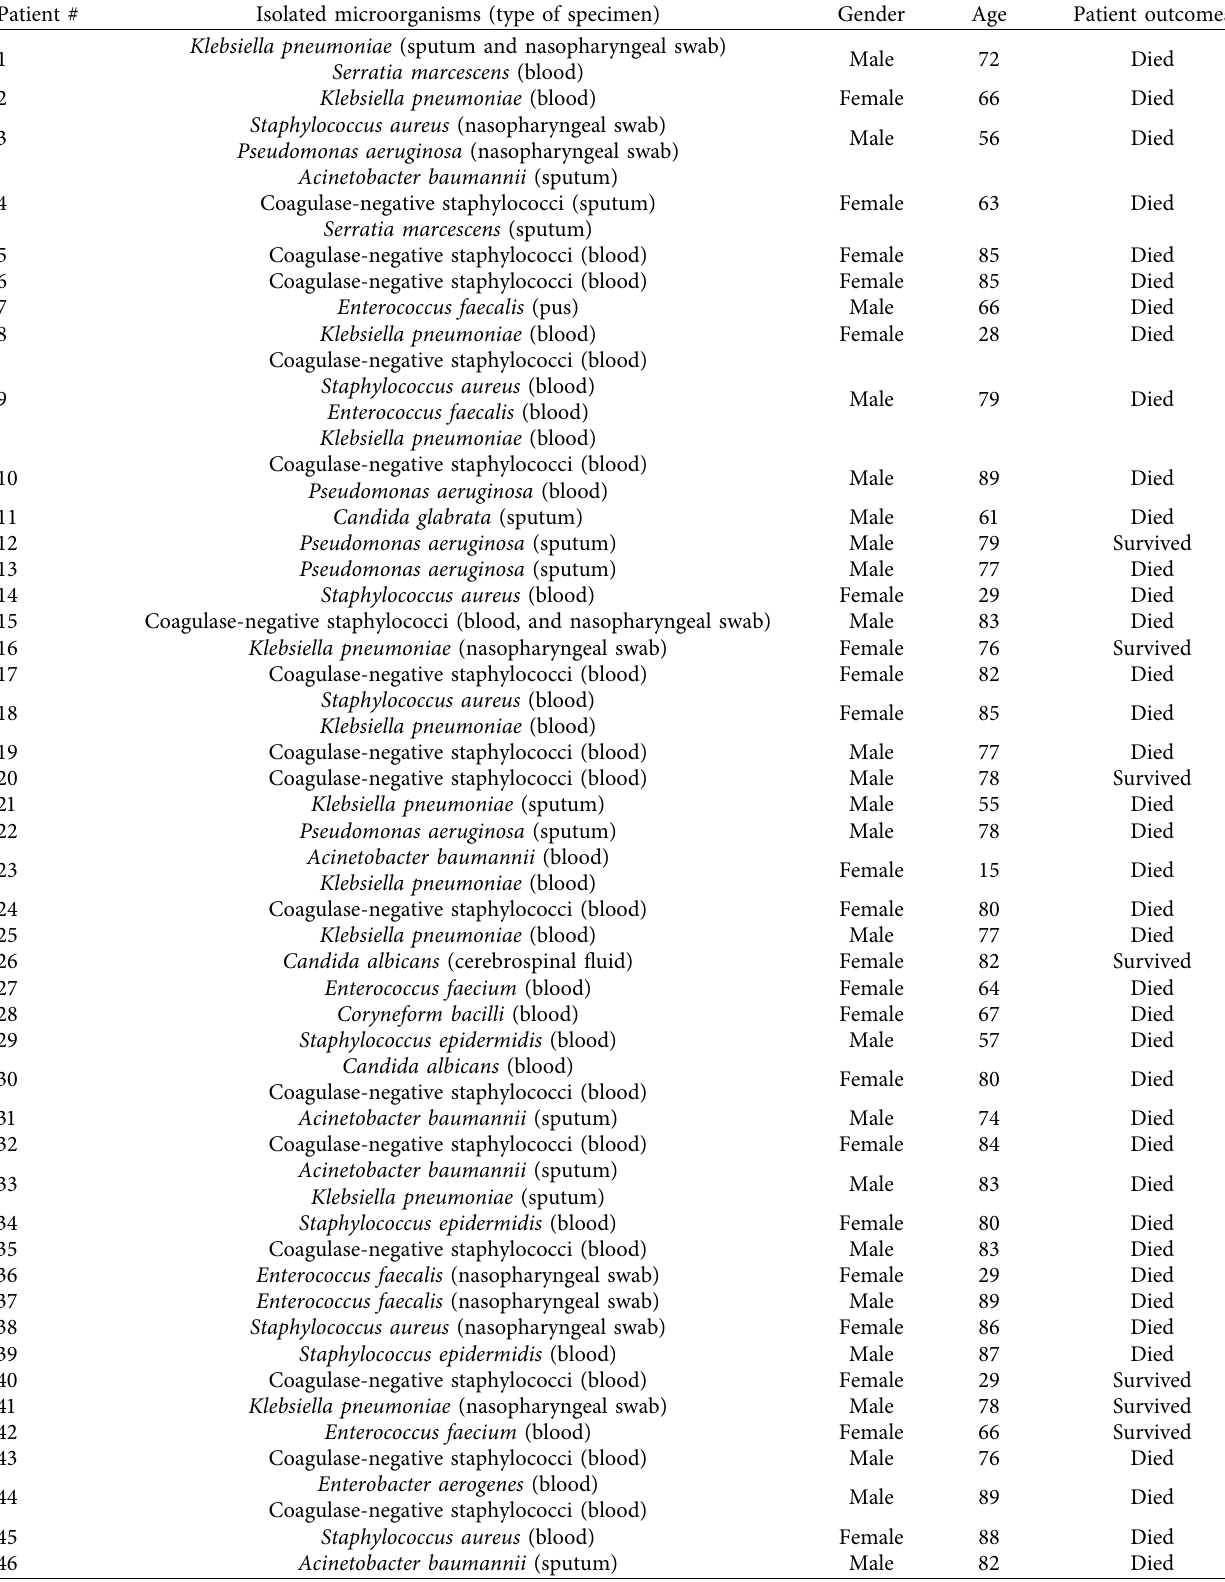
Table 1: General characteristics of bacterial and/or fungal coinfections among ICU COVID-19 patients. Patient # Isolated microorganisms (type of specimen) Gender